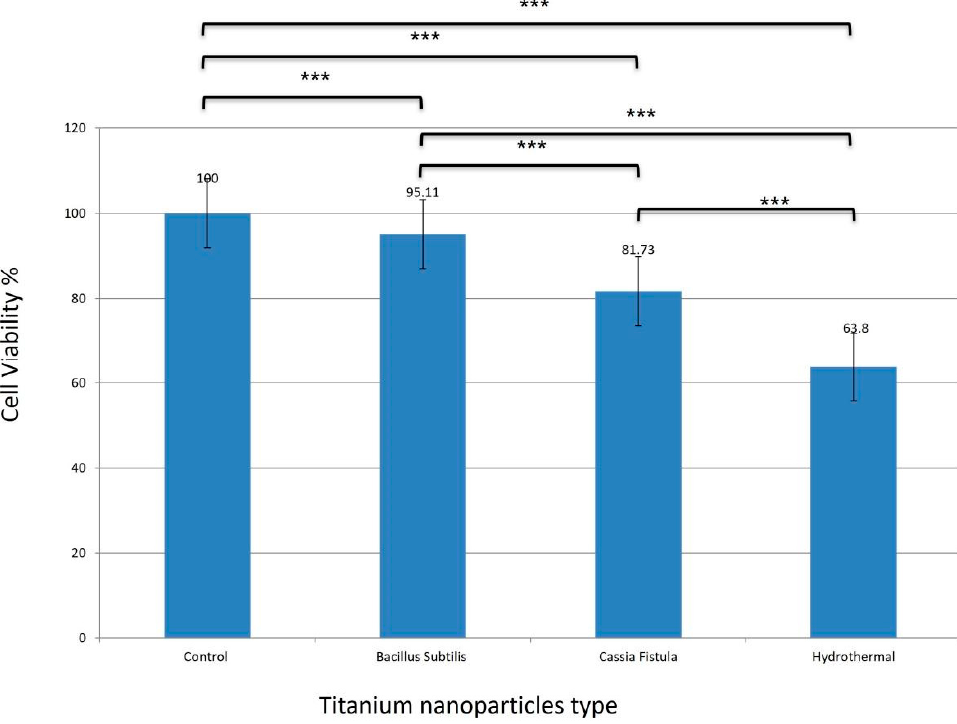
Figure 12. Cell Viability (%) of titanium nanoparticles formed by Bacillus subtilis , Cassia fistula and titanium tetrachloride at 31st day in comparison to control group (*** p < 0.001, error bars = S.E).